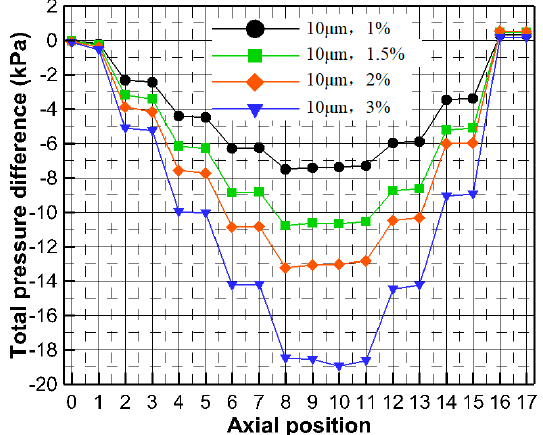
Figure 30. Axial variation of total pressure difference under water of different injecting rates.